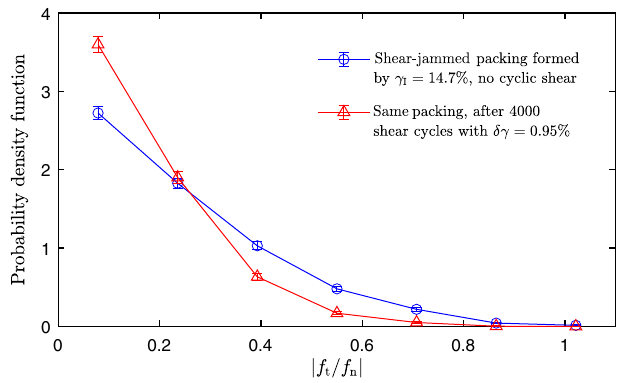
FIG. 6. The distribution of the ratio between the tangential and normal components of the contact vector force in the original shear-jammed packing (blue circles) and the corresponding ultrastable packing formed after cyclic shear (red triangles). 0.05 N). Curves from experiments with different γ qualitatively